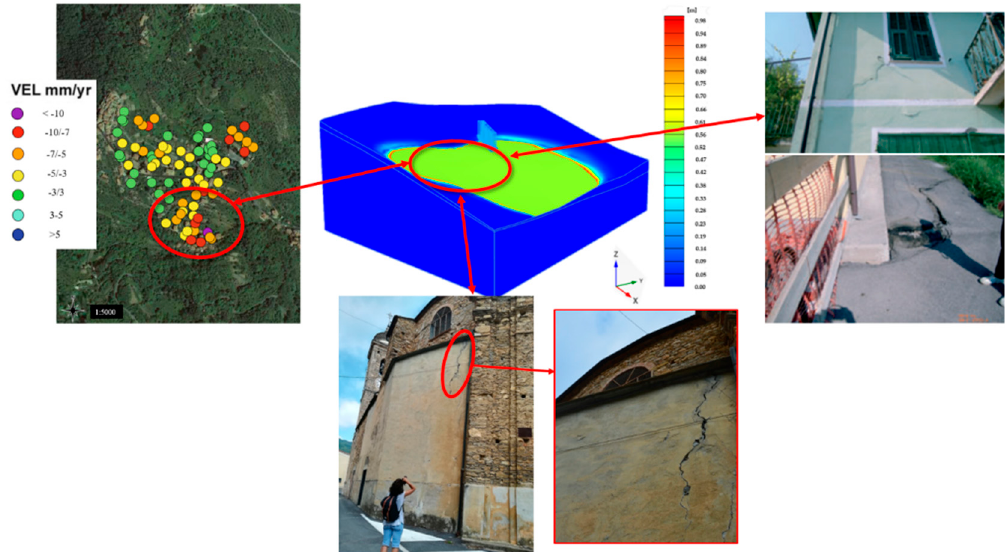
Figure 19. Model validation referred to the upper part of Ville San Pietro.